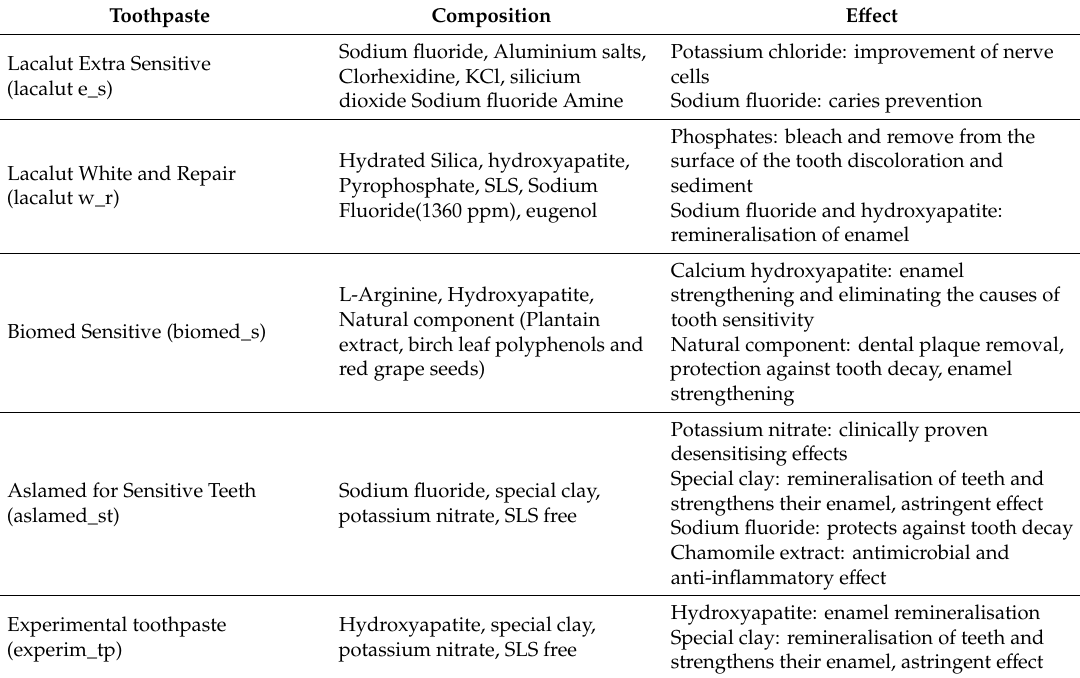
Table 1. Most importants ingredients and outcomes of commercial and experimental